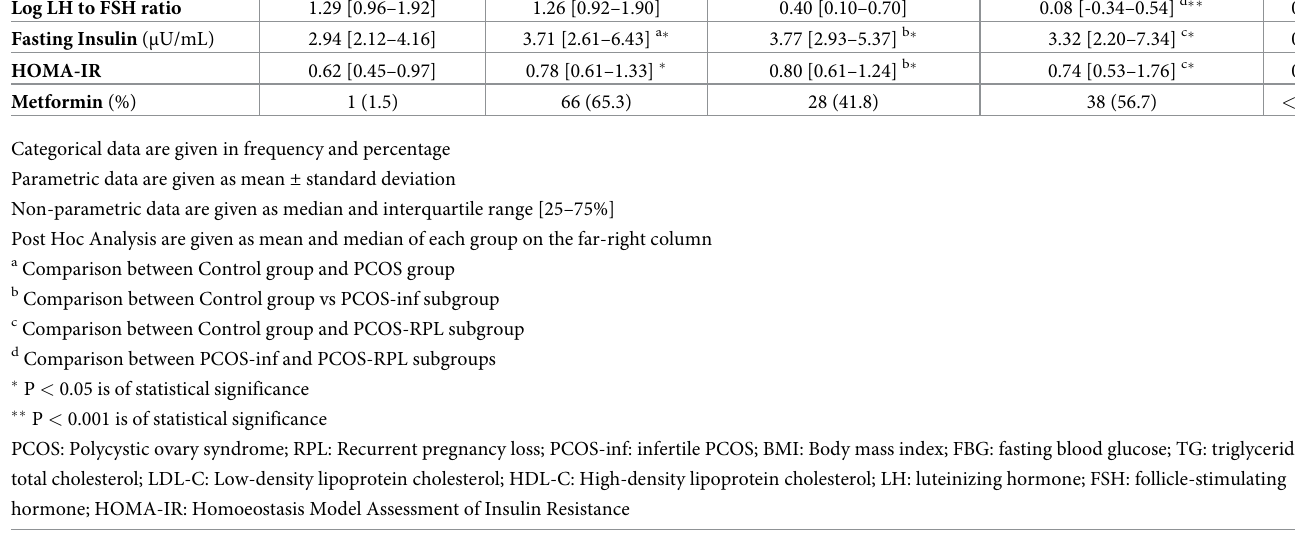
obese individuals than normal-weight in the control group, PCOS-Inf and PCOS-RPL groups. Intriguingly, overweight/obese subjects demonstrated lower Metrnl levels compared to normal weight subjects in whole sample and PCOS groups.